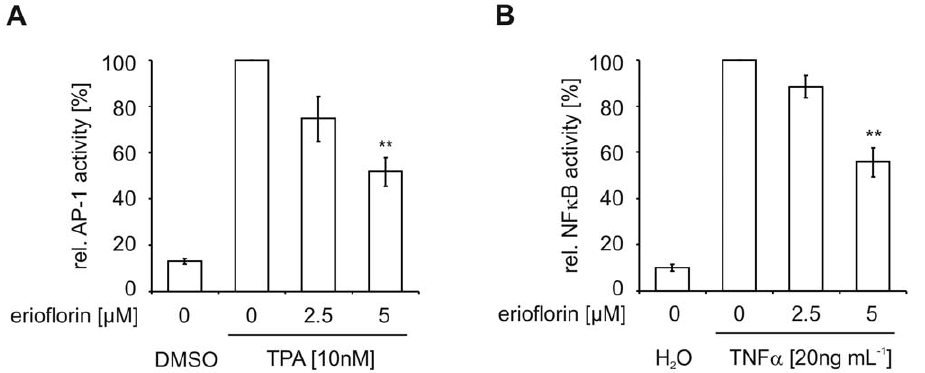
Figure 5. Erioflorin inhibits AP-1- and NF- k B-trancriptional activities. (A) HEK293 cells were co-transfected with an AP-1 firefly reporter and a renilla luciferase plasmid one day prior to experiments. Transfected cells were treated for 16 h with TPA (10 nM) with or without erioflorin (2.5 and 5 m M). Relative AP-1 activity was normalized to renilla luciferase and presented relative to TPA-only treated cells. (B) HEK293 cells were co-transfected with a NF- k B firefly reporter and a renilla luciferase plasmid one day prior to experiments. Transfected cells were treated for 16 h with TNF a (20 mg mL –1 ) with or without erioflorin (2.5 and 5 m M). Relative NF- k B activity was normalized to renilla luciferase and presented relative to TNF a -only treated cells. All data are given as means 6 SEM (n $ 3, **p ,